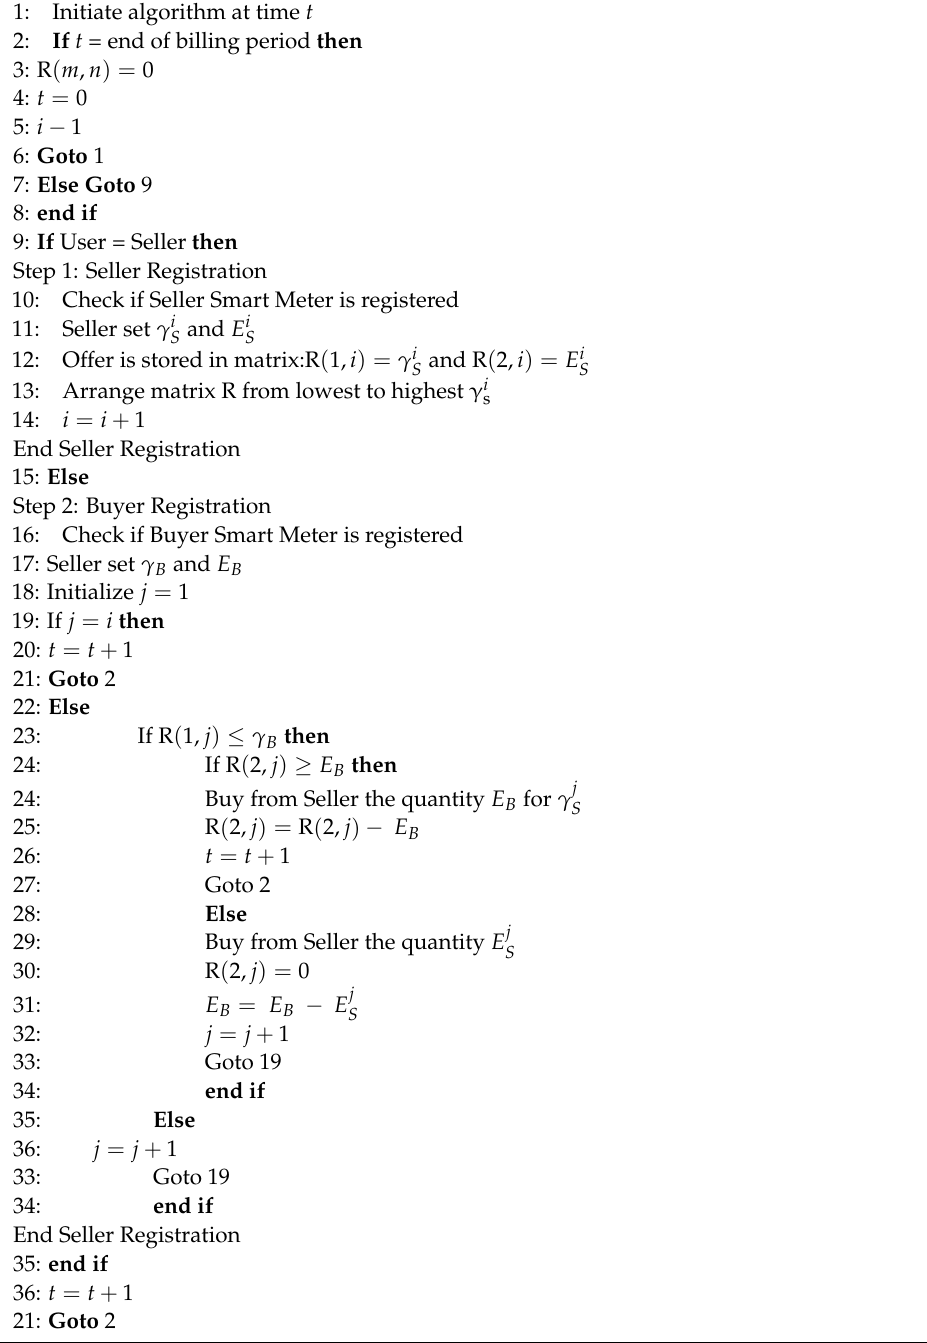
Algorithm 1 Energy Cap and